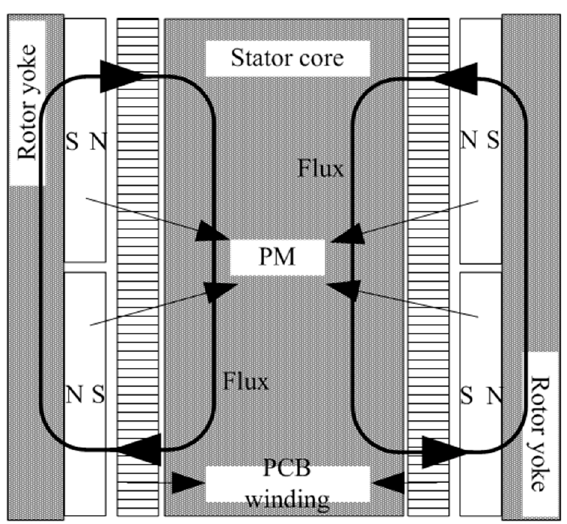
Figure 5. Analytical model of the generalized magnetic circuit.